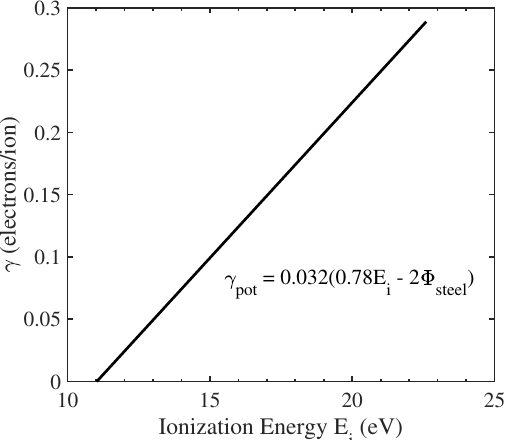
Figure A1. PE yield as a function of ionization energy for stainless steel. Steel’s work function is 4.3eV [83]. The equation shown comes from